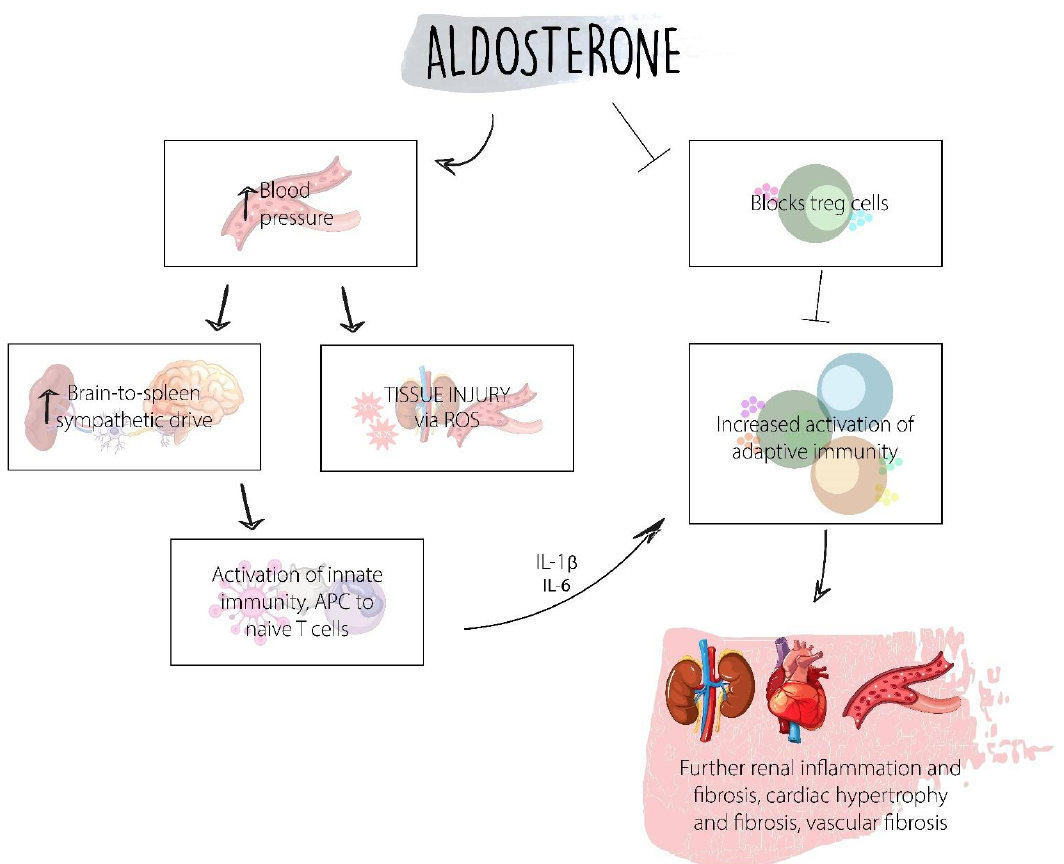
Figure 3. Aldosterone elevated blood pressure leading to tissue injury via ROS, increasing the brain to spleen sympathetic drive, which leads to activation of innate immunity. Cytokines such as IL-6 and IL-1 β lead to the activation the adaptive immune system, which leads to further tissue inflammation and